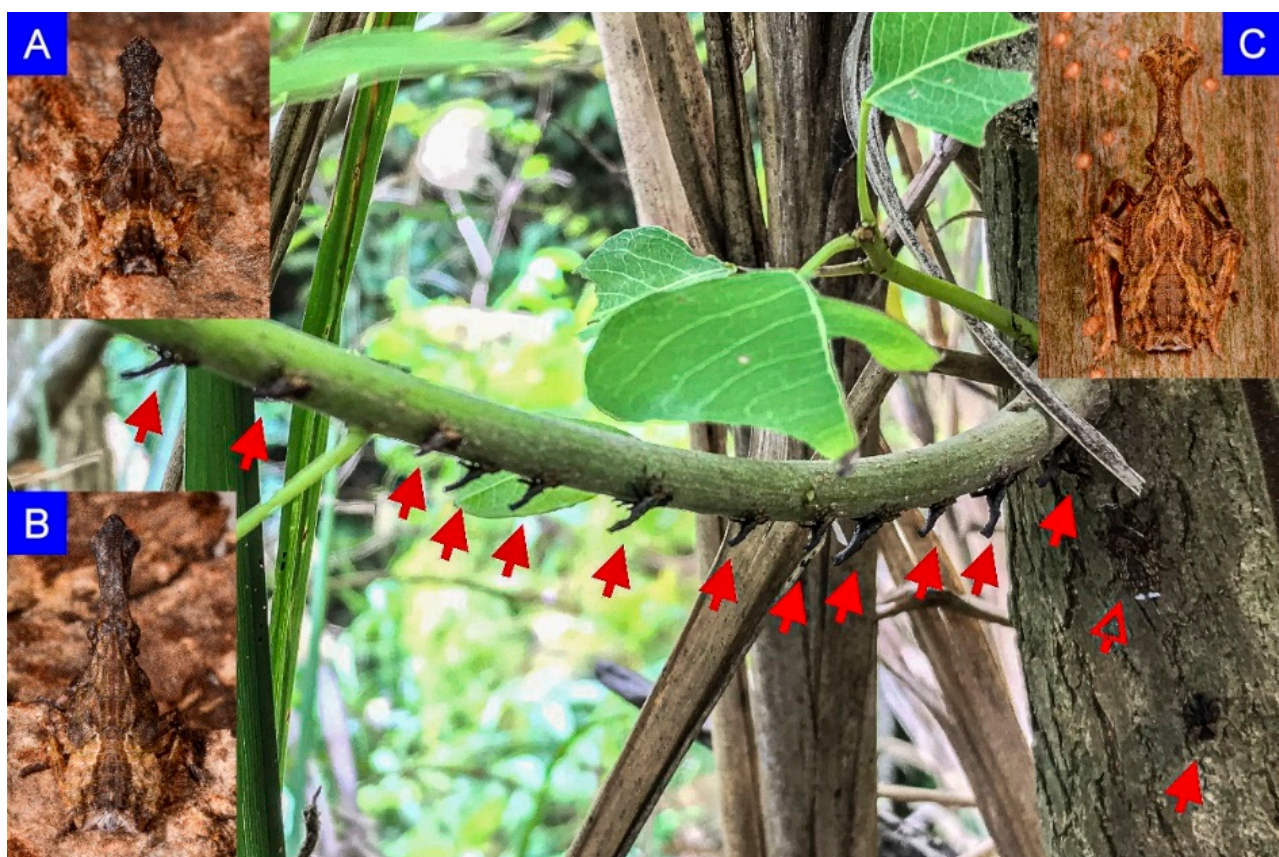
Figure 1. The nymphs of Pyrops candelaria usually stay along the underside of the lower branch, with an interval among each other. In this photograph, several second instars ( A ) and third instars ( B ) were found on a branch of Triadica sebifera . Each solid arrow points to a nymph. Besides, a fourth instar ( C ) of Pyrops watanabei , indicated by a hollow arrow, was observed on the trunk near the base of the green branch.